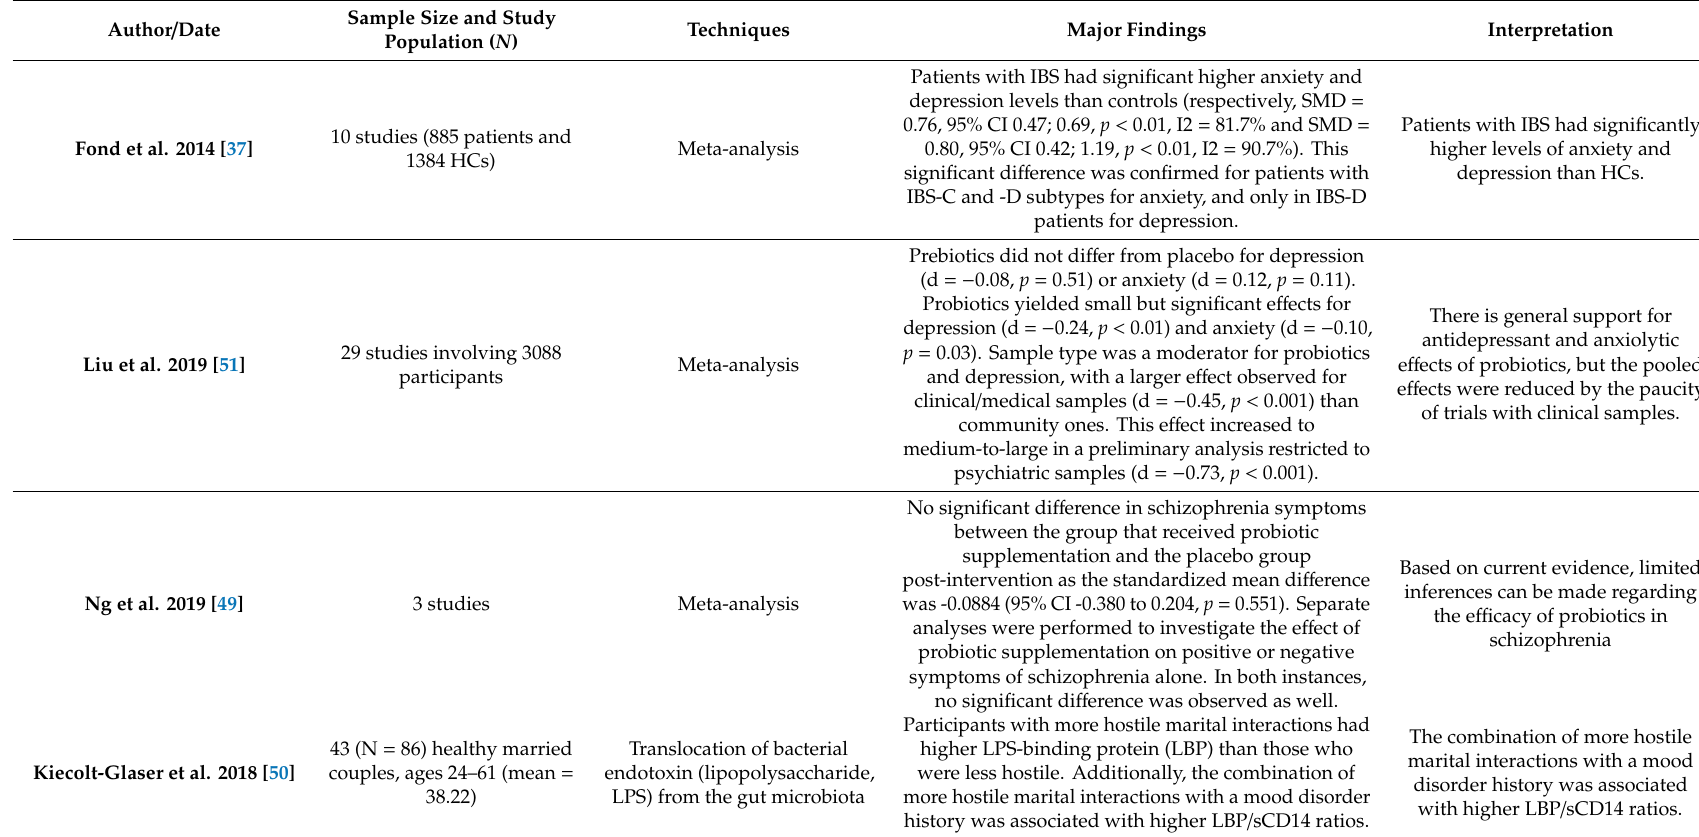
Table 1. Human studies exploring microbiota disturbances in major depression and the interest of microbiota-orientated